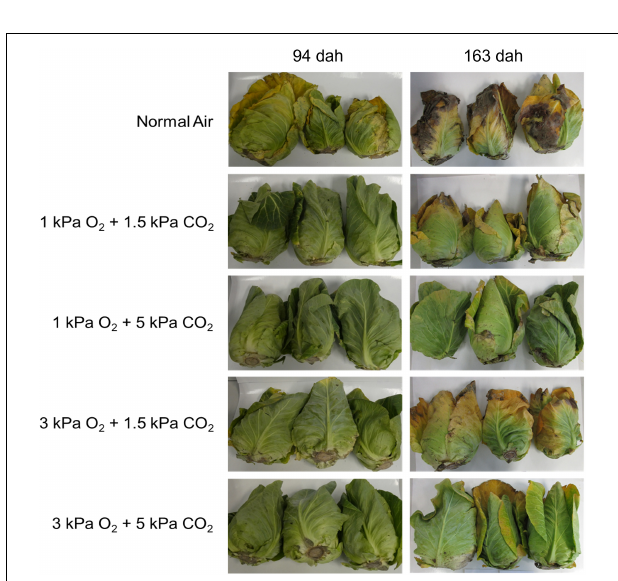
FIGURE 2 | Cabbage heads 94 dah and 163 dah in different storage conditions on the day of opening the storage containers (shelf life zero days,